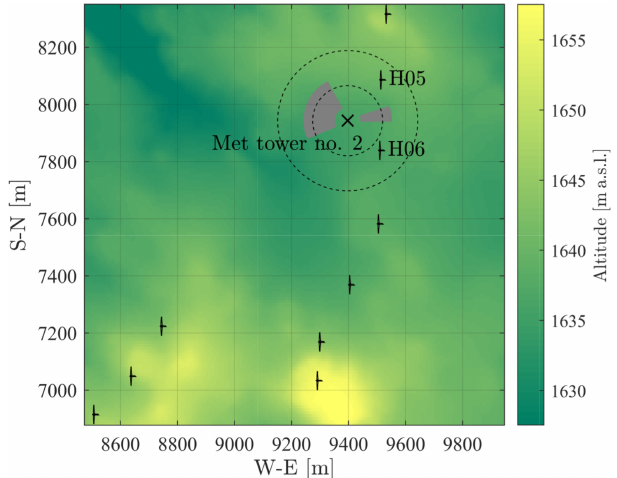
Figure 18. Met tower and turbines selected for the nacelle trans- fer function estimation. The directions highlighted in gray repre- sent the valid wind sectors unaffected by turbine wake interactions. The dashed circles bound the allowed range of distances from the tower in compliance with IEC standard 61400-12-1 (International Electrotechnical Commission 61400-12-1,